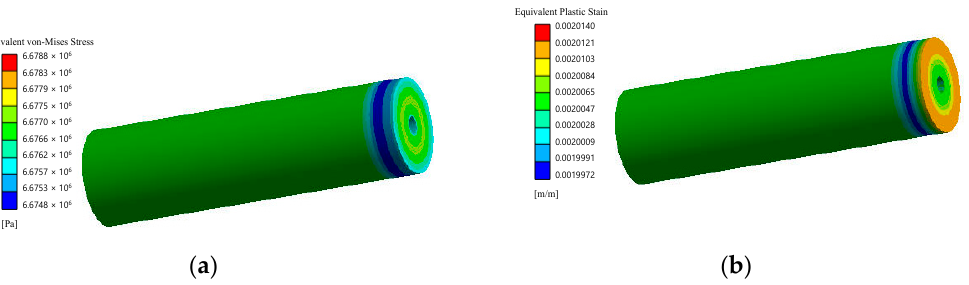
Figure 14. Equivalent stresses according to von Mises stress ( а ) and residual (plastic) relative lin- ear strains ( b ) for composite with spherical filler at the moment of full compression (second stage).